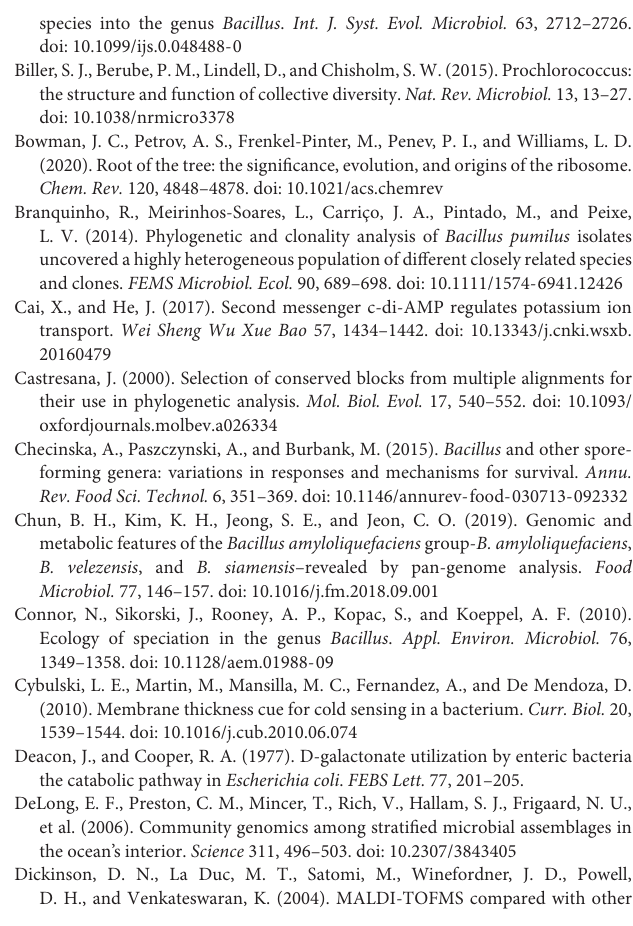
Supplementary Figure 1 | Phylogenetic tree of Bp group strains generated with Mash software. Supplementary Figure 2 | Hierarchical clustering using core COGs. Supplementary Table 1 | Information of marine Bp group strains used for analyzing. Supplementary Table 2 | ANI values between each Bp group strain. Supplementary Table 3 | DDH values between each Bp group strain. Supplementary Table 4 | COG distribution of niche-specific genes in the three species. Supplementary Table 5 | Intra-species niche related specific genes of the three species. Supplementary Table 6 | B. pumilus strains information containing both phage and